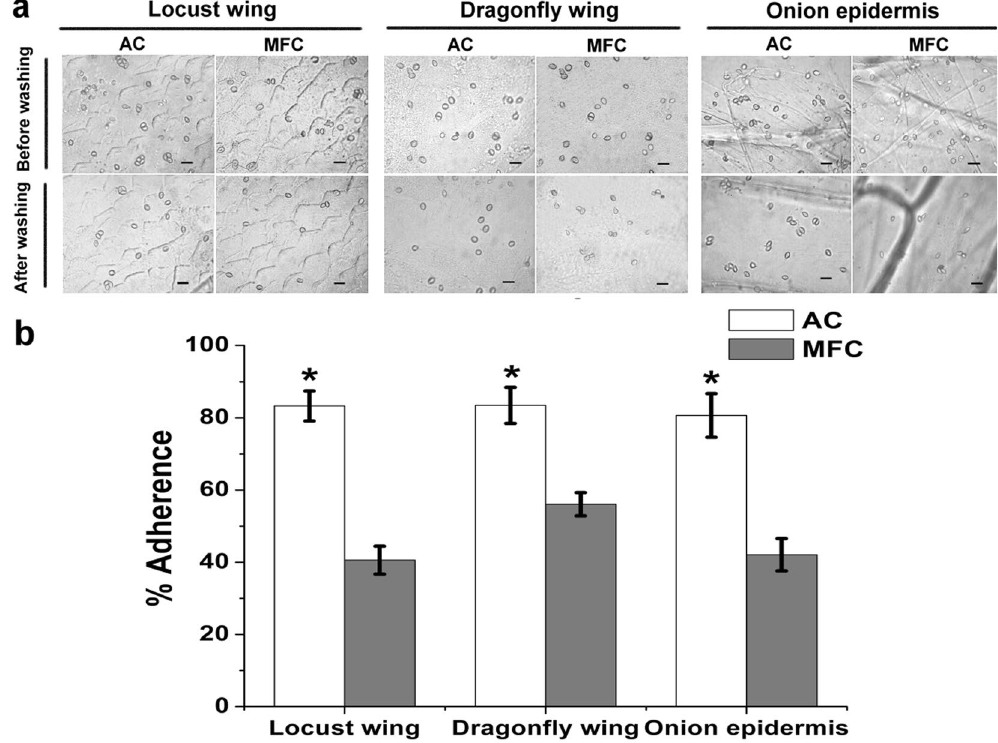
Figure 5. Adherence assays. ( a ) Binding of two Hirsutella satumaensis spores to locust wing cuticle, dragonfly wing and onion epidermis respectively in spite of washing with 0.05% Tween 20. The upper graph show the adhesion of AC and MFC to insect- and plant-derived epidermal tissue; the below display the residual spores after simulated rain erosion. Bar = 10 μ m. ( b ) Bar graph quantifying adherence of two conidia to locust wing, dragonfly wing cuticle and onion epidermis. MFC display an approximately 40% reduction in adherence to the surface of three material despite washing relative to the AC. Mucilage is principally responsible for the ability of conidia to adhere to insect hosts and plant surfaces. Statistical analysis was performed using a one-way ANOVA. Error bars are standard deviations of three trials and panels are representative of at least 2 independent experiments, * p <